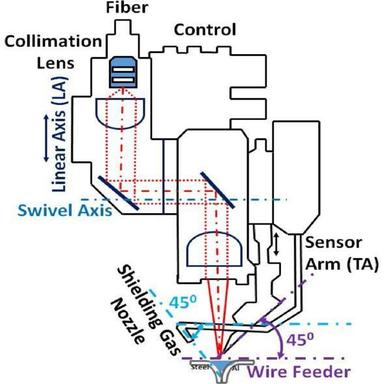
Schematic of laser brazing experimental setup.